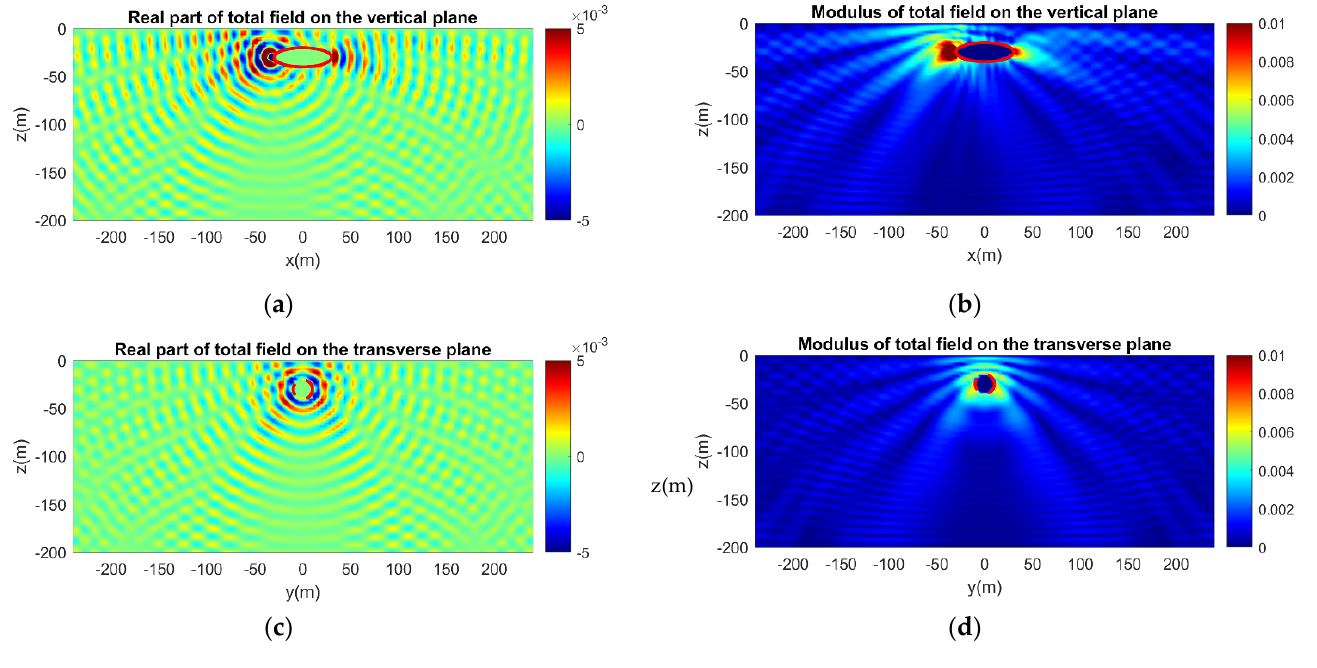
Figure 14. Calculated acoustic field in the ocean waveguide considering scattering of a monopole source field by an acoustically soft ellipsoid, with the effect of rigid sea bottom at depth h = 200 m. ( a ) Real part and ( b ) modulus of the acoustic field on the vertical plane. ( c ) Real part and ( d ) modulus of the acoustic field on the transverse plane.